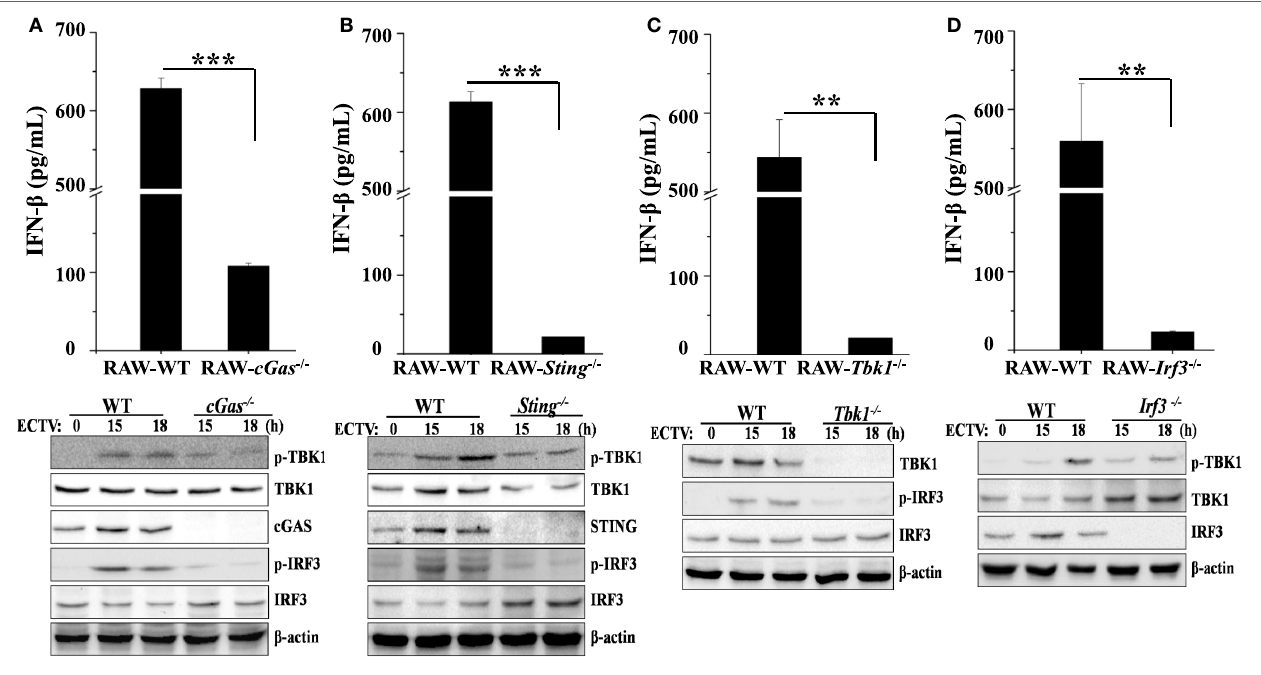
FigUre 4 | The cGas–Sting–Tbk1–Irf3 pathway contributes to the induction of IFN- β in RAW264.7 cells by ectromelia virus (ECTV). cGas − / − (a) , Sting − / − (B) , Irf3 − / − (c) , and Tbk1 − / − (D) RAW264.7 and wild-type (WT) cells were infected with ECTV at an MOI of 5. Supernatants were collected 18 h post-infection (hpi) for determining the concentrations of IFN- β by using enzyme-linked immunosorbent assay (ELISA), and cells were collected at 15 and 18 hpi for western blot analysis using anti-phospho-Tbk1, anti-Tbk1, anti-phospho-Irf3, and anti-Irf3. β -Actin was used as a loading control. The ELISA data are averaged from three independent experiments in biological triplicate. Results of western blot analysis shown are representative of three independent experiments. The data were analyzed using a t -test on SPSS software (** P ≤ 0.01 and *** P ≤